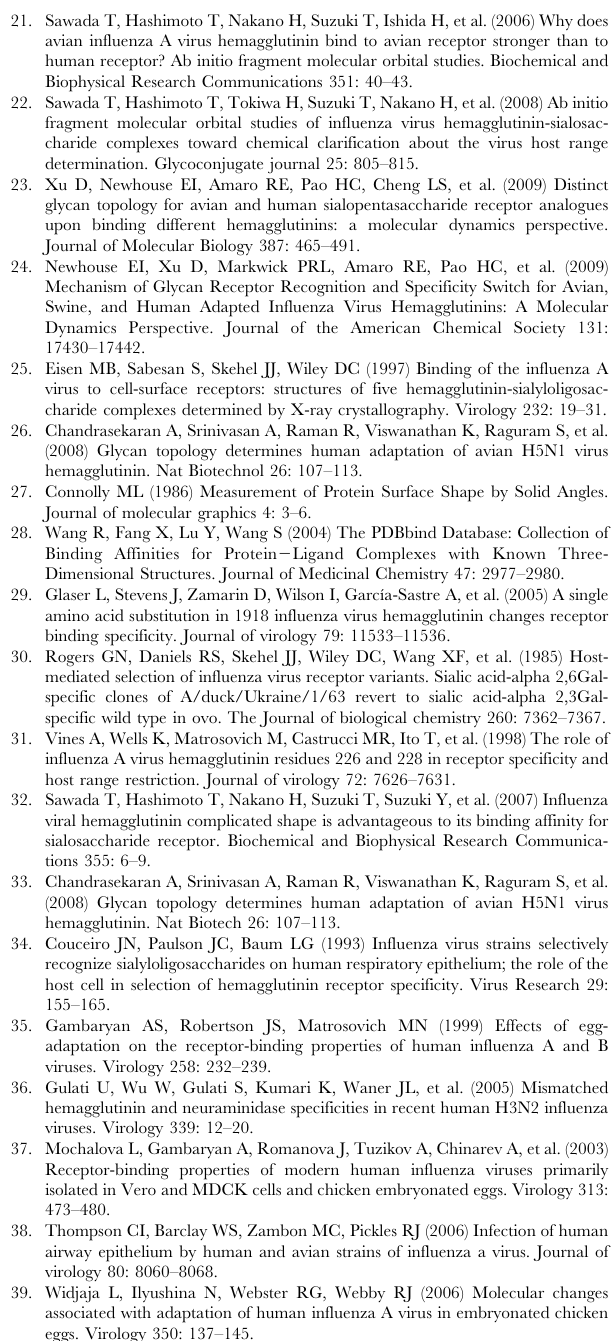
Table S3 Validation of the computational method using well characterized